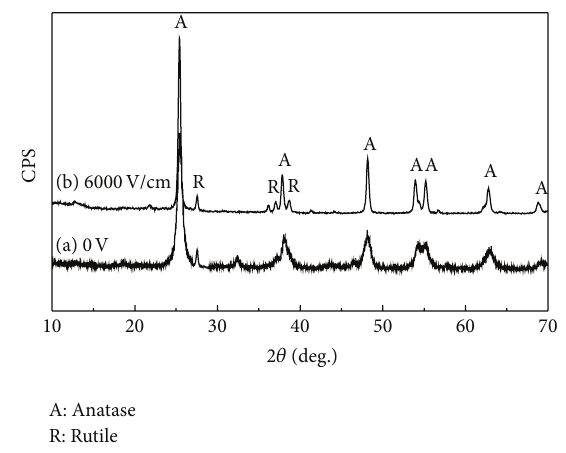
Figure 2: X-ray diffraction patterns of the composite film annealed at 500 ∘ C for 1h: (a) 0 V and (b) 6000